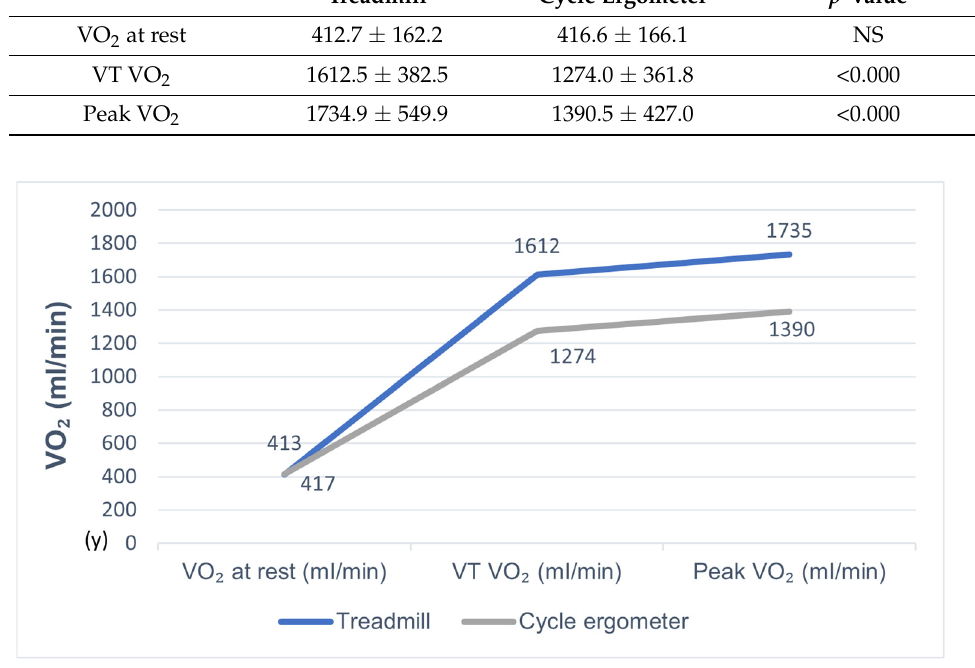
Figure 1. VO 2 variation during